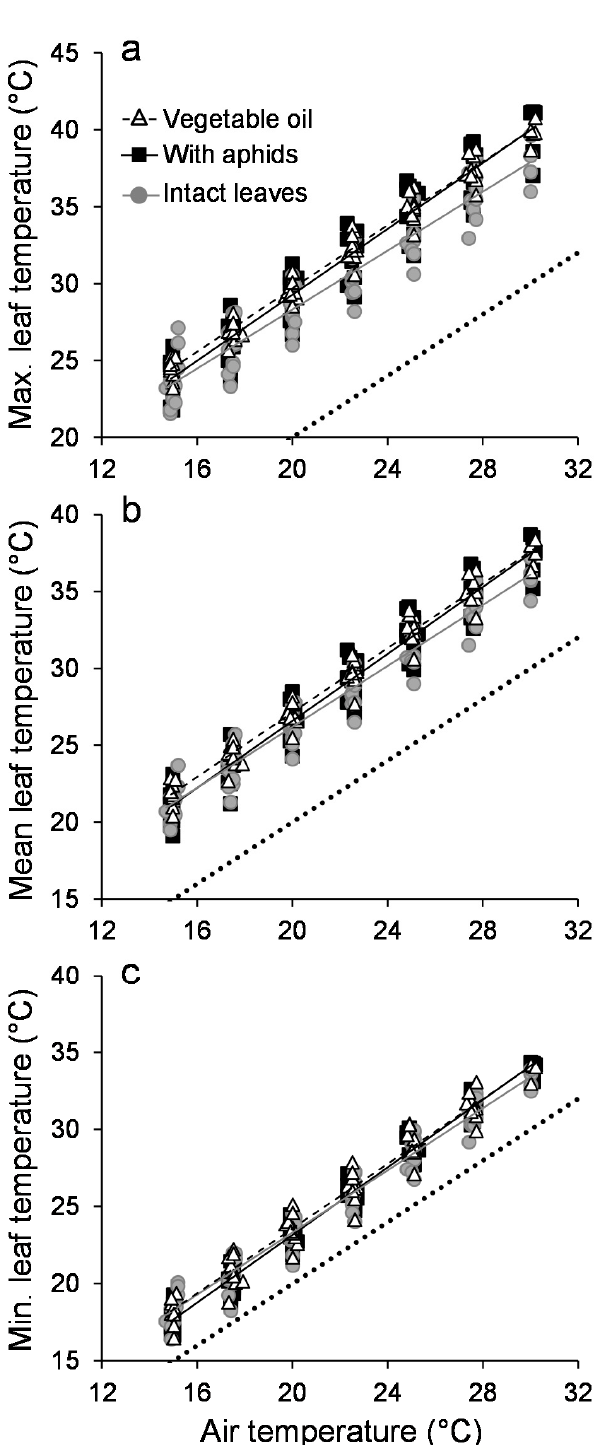
Figure 2. Composition of the leaf surface thermal heterogeneity. Dynamics of ( a ) the maximal leaf temperature, ( b ) the mean leaf temperature and ( c ) the minimal leaf temperature as function of air temperature for intact leaves (grey circles), leaves covered with vegetable oil (white triangles) and leaves infested with green apple aphids (black squares). Lines represent linear regression models for illustrating the trends. The dotted line represents the equality line. The minimal and maximal temperatures correspond to the mean temperature of the 5% coolest and hottest pixels at the leaf surface, respectively.